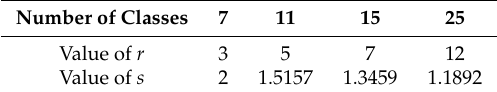
Table 4. Values of r and s used in different